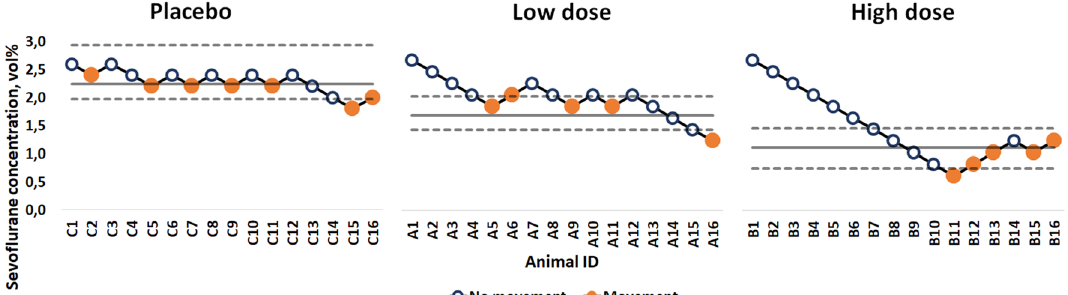
Figure 2. Bootstrap estimates for the MAC (solid horizontal lines) and the confidence intervals (dashed horizontal lines). Gross purposeful movements are shown as full dots, and no movements are shown as circles. X-axis: Animal ID, Y-axis: sevoflurane concentration (vol%).